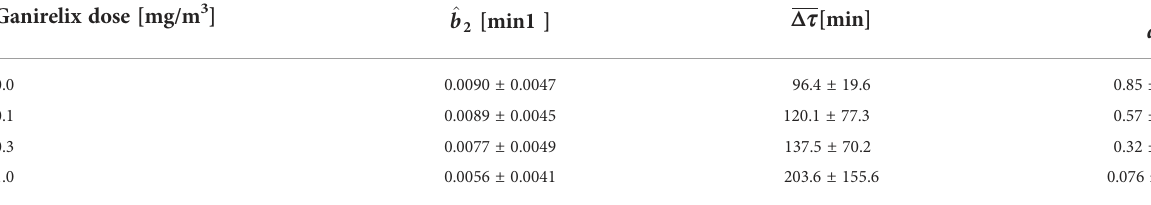
TABLE 1 Parameter estimates with standard deviations for escalating doses of ganirelix. Ganirelix dose [mg/m 3 ]